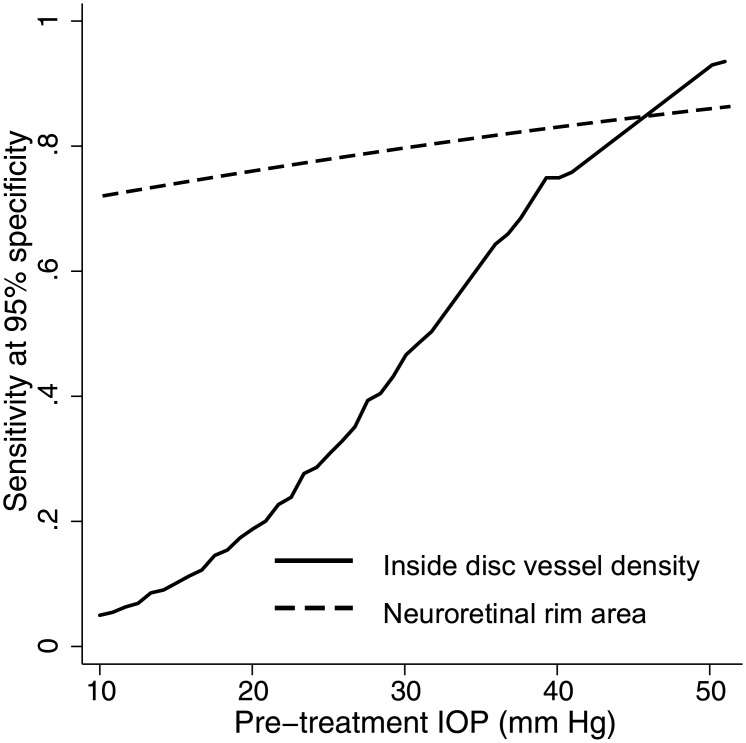
Effect of pre-treatment intraocular pressure on the diagnostic ability of optic nerve head vessel density and rim area.Sensitivity at 95% specificity of optic nerve head vessel density and rim area according to the pre-treatment intraocular pressure at a mean deviation on visual fields of -5 dB.